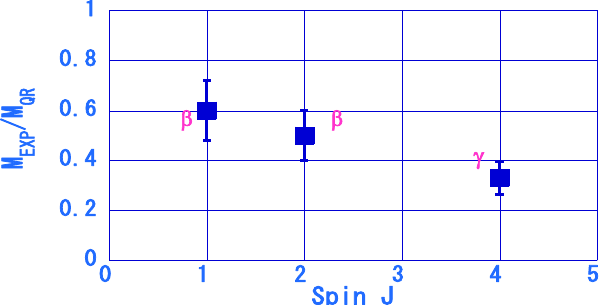
Figure 13. Quenching coefficients g ef f / g A and the spin J for GT( J = 1), SD ( J = 2) and HD ( J = 4) NMEs. A M EXP and M QR are the experimental and pnQRPA model NMEs,